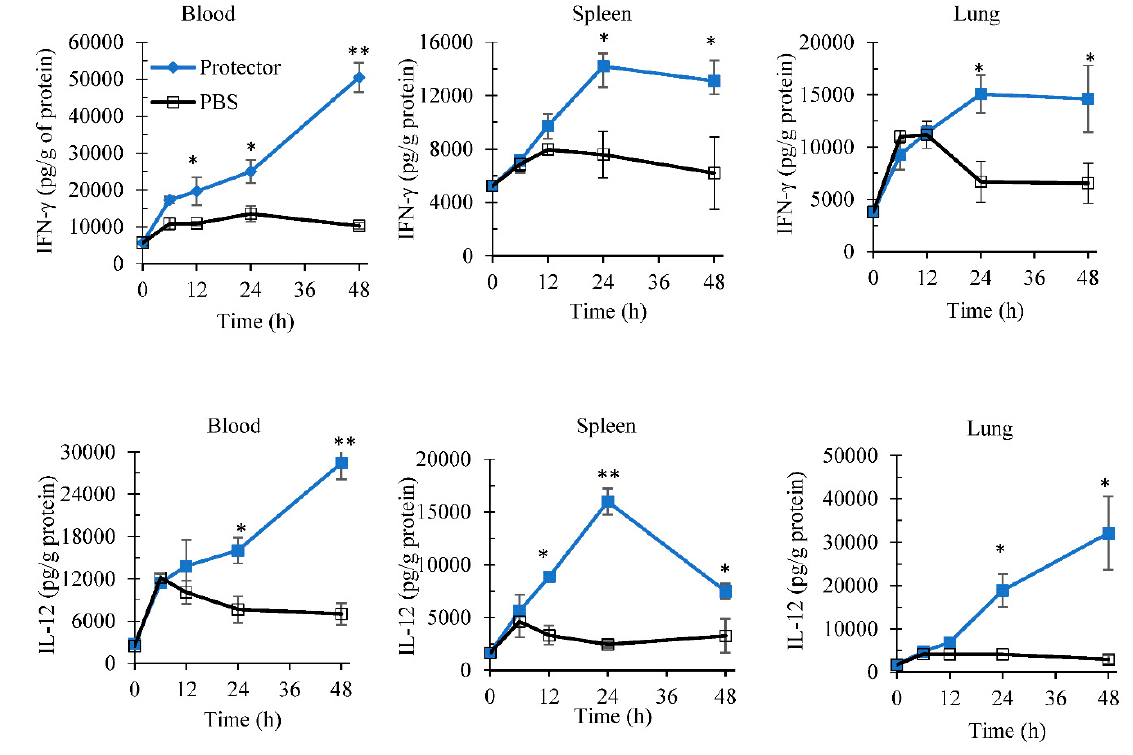
Figure 2. Intraperitoneal administration of “Protector” (10 µg) demonstrated a kinetic production profile of IFN- γ and IL-12 in blood, spleen and lungs. Mice were injected i.p. with “Protector” or sterile PBS, and at different time tissues were obtained, processed for cytokine extraction, and then kept frozen until analysis (* and ** indicate p < 0.05 and p < 0.01 to their time-point control (PBS), respectively).